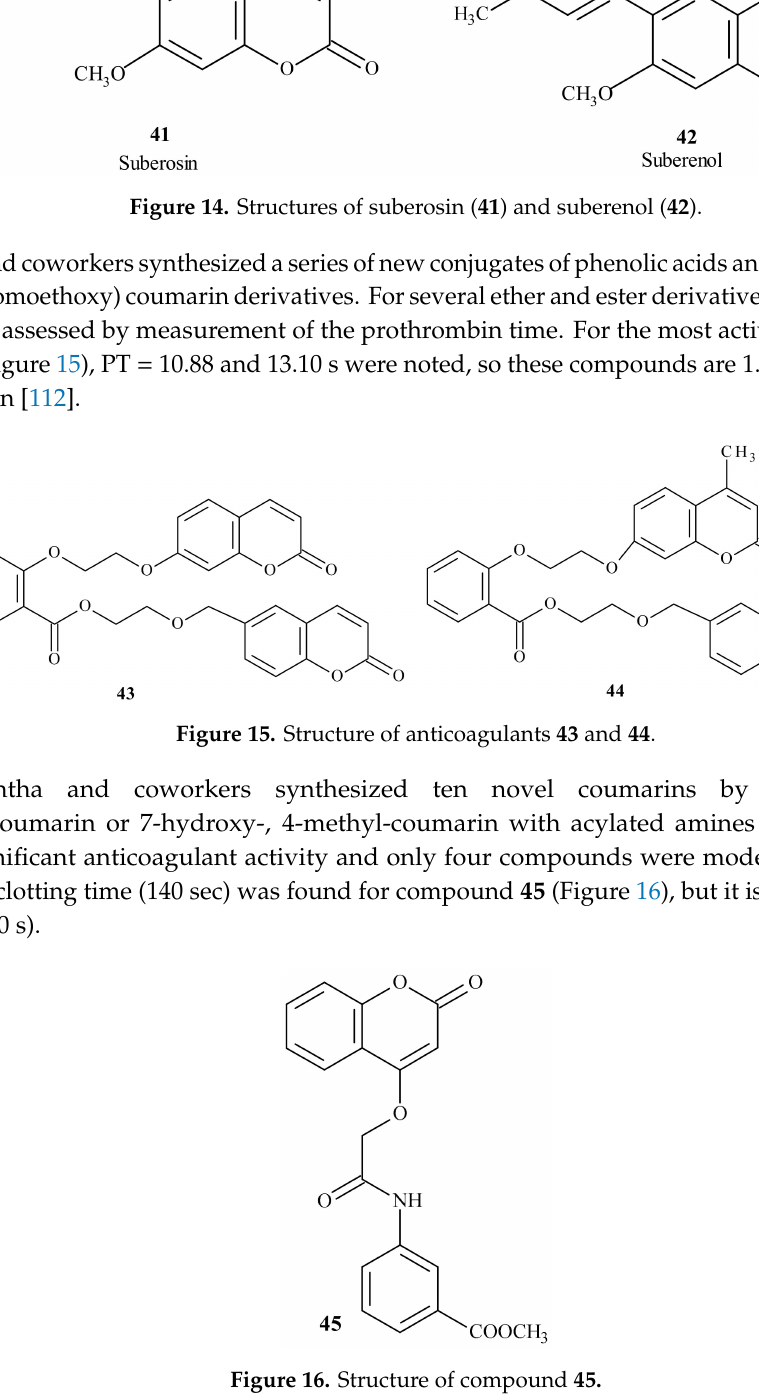
Figure 16. Structure of compound